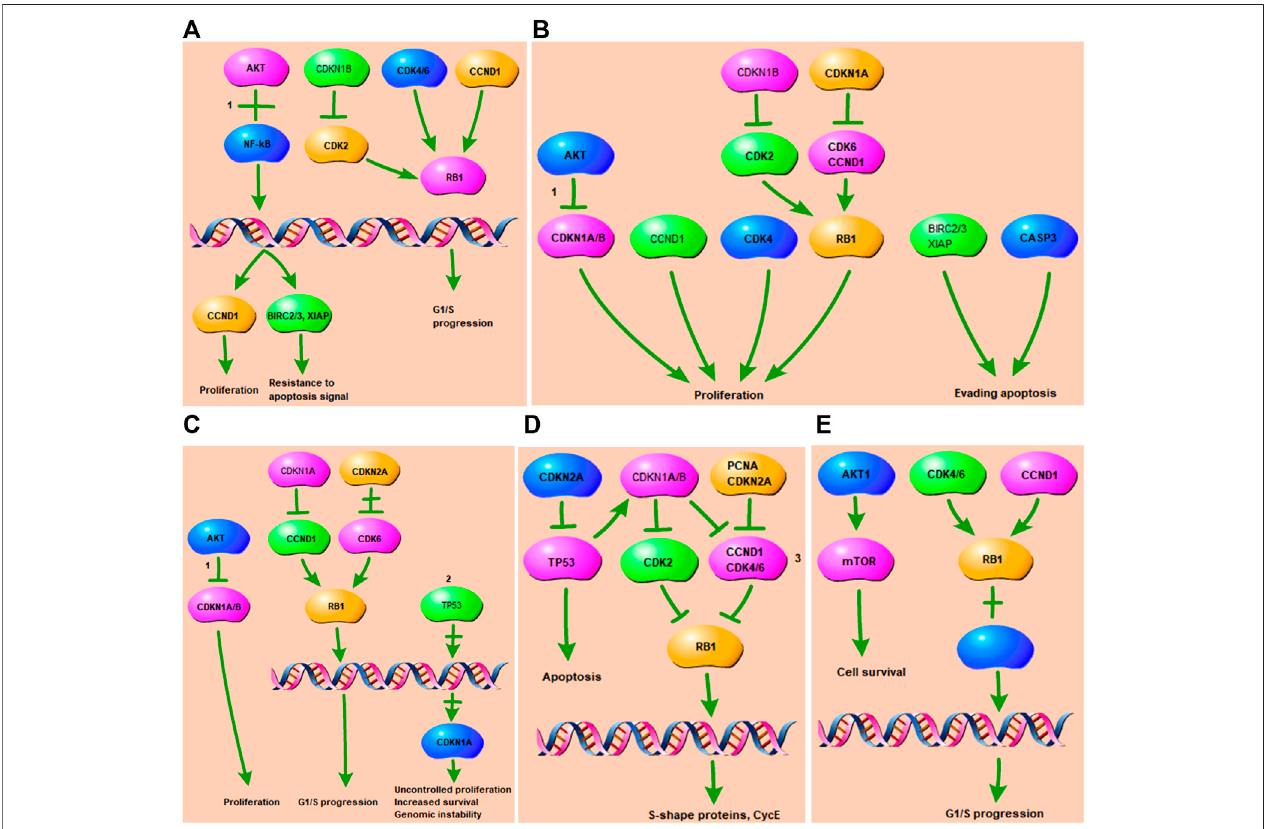
FIGURE 5 | Tanshinone-targeted genes related part of the top two KEGG pathways. 1 PI3K-Akt signaling pathway. 2 p53 signaling pathway. 3 MAPK signaling pathway. (A) Tanshinone-targeted genes related part of the Small cell lung cancer pathway. PI3K-Akt signaling pathway is involved in the process, resulting in proliferation, resistance to apoptosis signal, G1/S progression; (B) Tanshinone-targeted genes related part of the Pathways in cancer. PI3K-Akt signaling pathway is involved in the process, resulting in proliferation, evading apopsis. (C) Tanshinone-targeted genes related part of the Chronic myeloid leukemia pathway. PI3K-Akt and p53 signaling pathway are involved in the process, resulting in proliferation, uncontrolled proliferation, G1/S progression, genomic instability, increased survival. (D) Tanshinone-targetedgenesrelatedpartoftheCellcyclepathway.MAPKsignalingpathwayisinvolvedintheprocess,resultinginapoptosis,S-shapeproteins,CycE. (E) Tanshinone-targeted genes related part of the Glioma pathway, resulting in cell survival and G1/S progression.